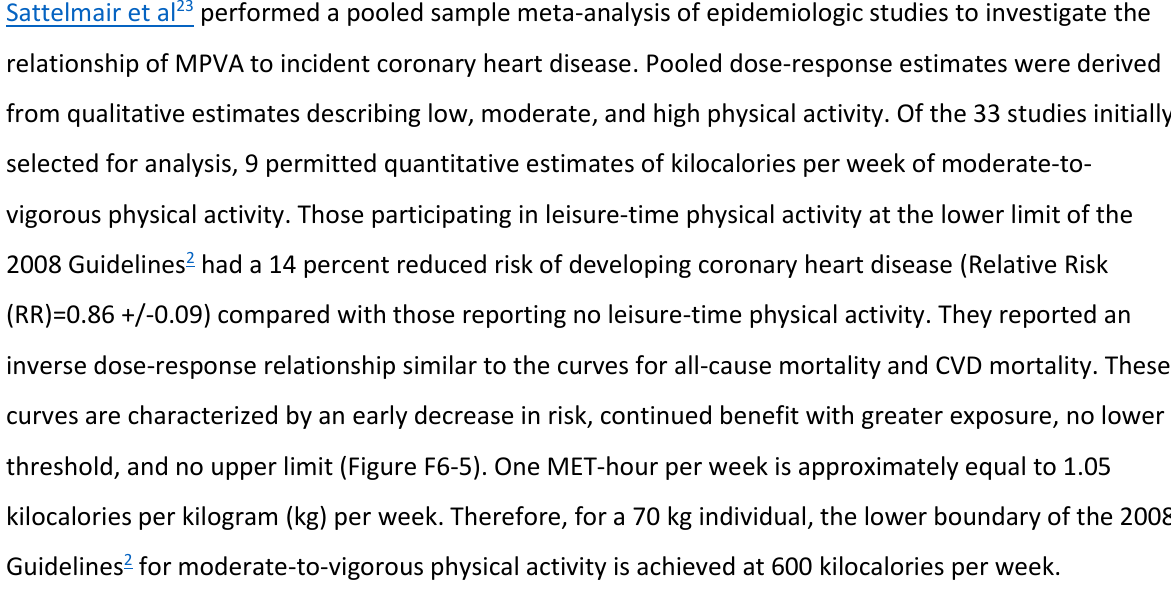
Figure F6-5. Plot with Spline and 95% Confidence Intervals of Relative Risk of Coronary Heart Disease by Kilocalories per Week of Leisure-time Physical Activity